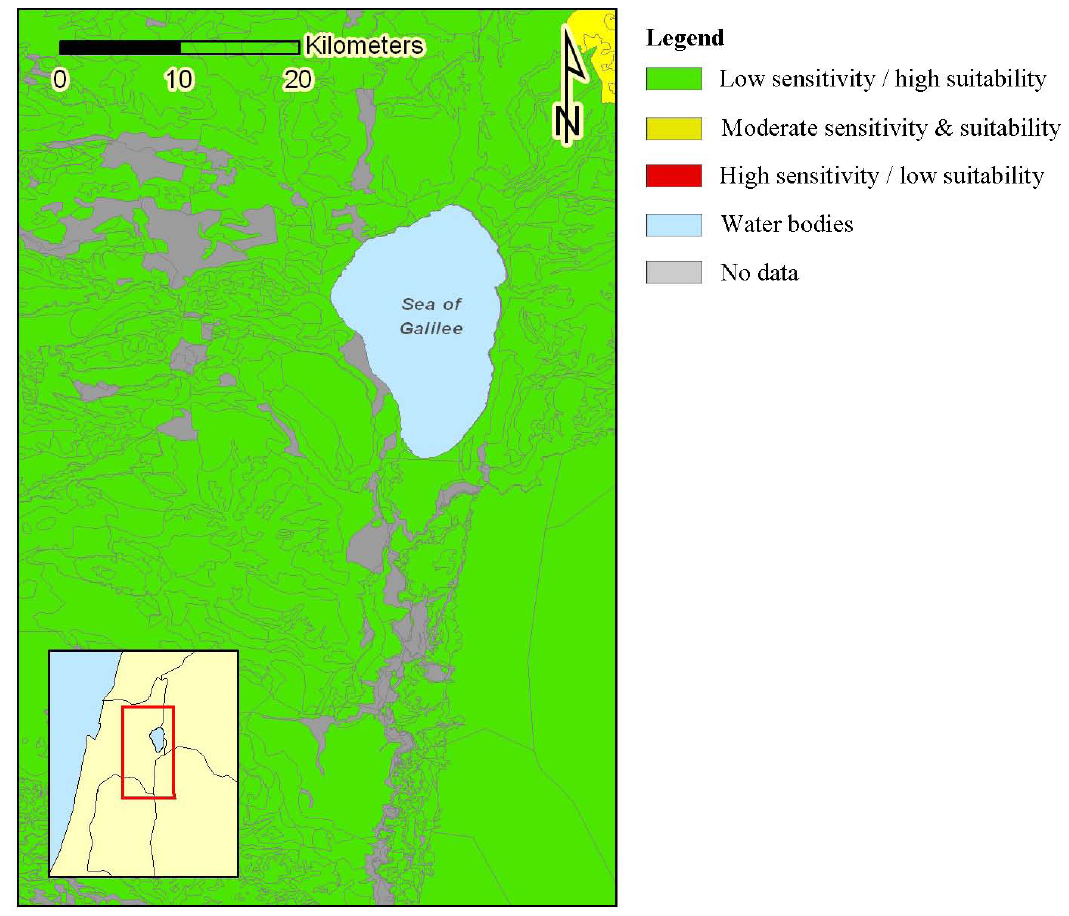
Figure 2. Cut-out of the assessment map visualizing sensitivity A: Sensitivity towards the mobilization of inorganic adsorbable contaminants (scale 1: